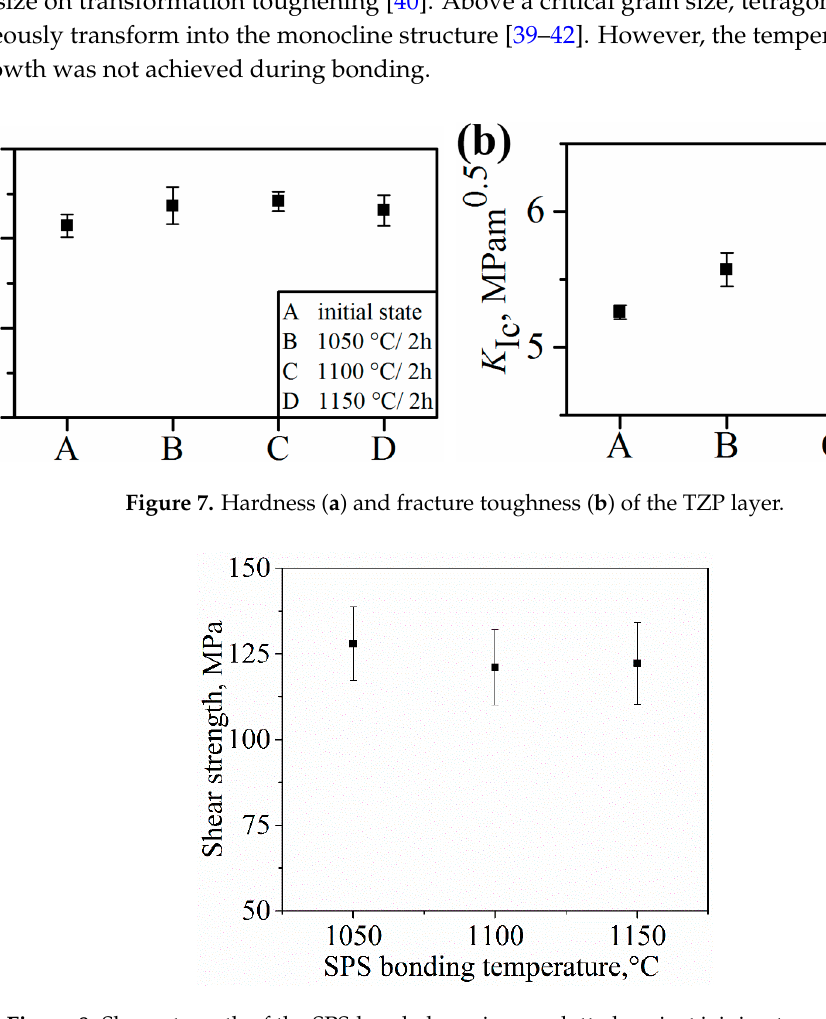
Figure 8. Shear strength of the SPS-bonded specimens plotted against joining temperature.